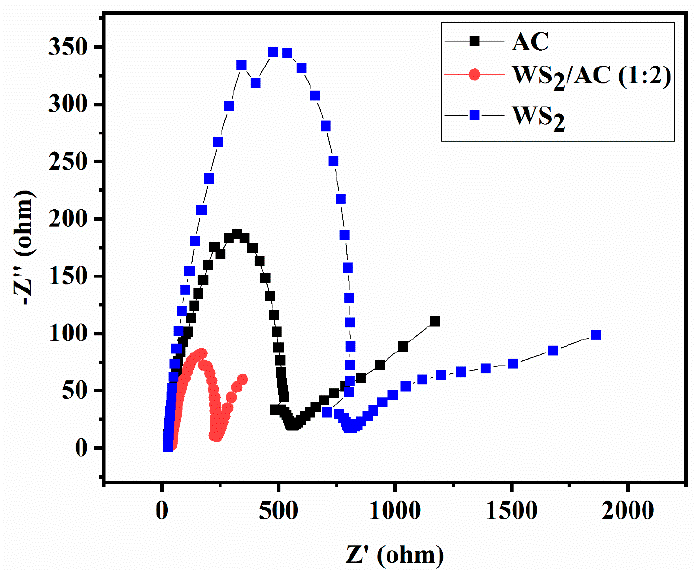
Figure 6. Nyquist plot of the DSSCs assembled with different counter electrodes (WS 2 , AC, and WS 2 /AC).